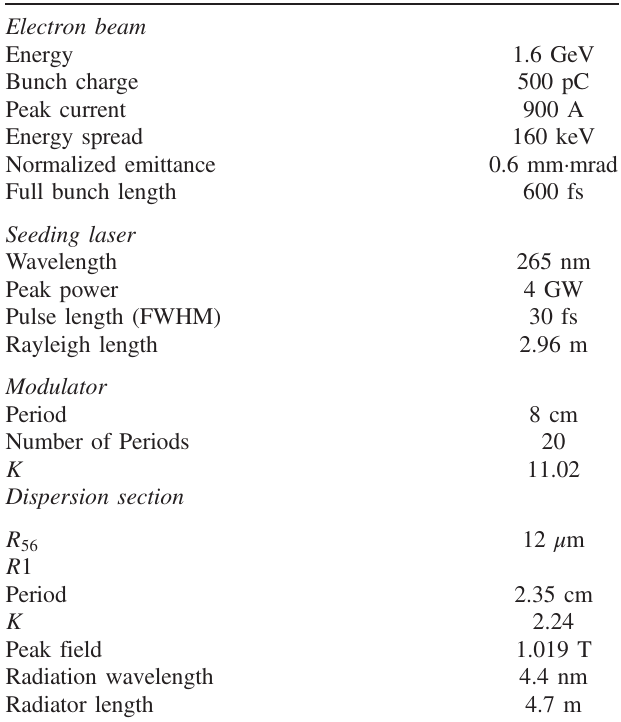
TABLE I. Main parameters of the SXFEL user